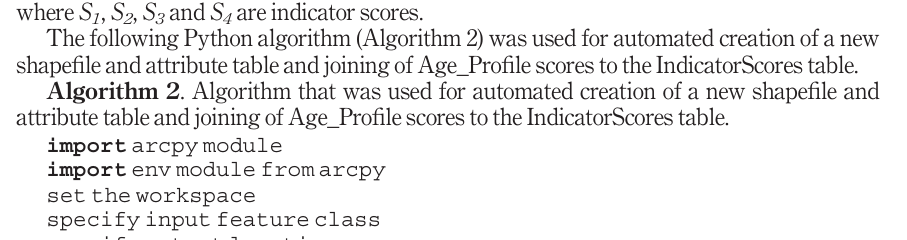
Algorithm 2 . Algorithm that was used for automated creation of a new shape fi le and attribute table and joining of Age_Pro fi le scores to the IndicatorScores table. import